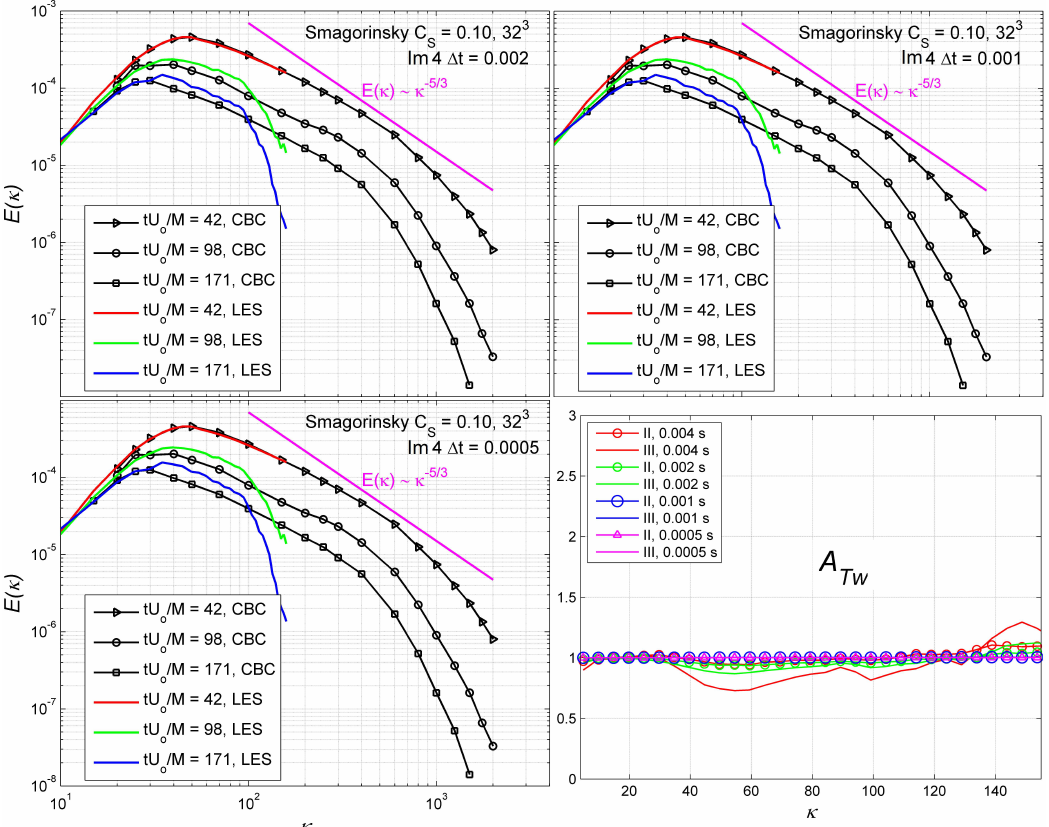
Figure 6. Energy spectra obtained using C S = 0.1 on a 32 3 grid with the Im4 and different time